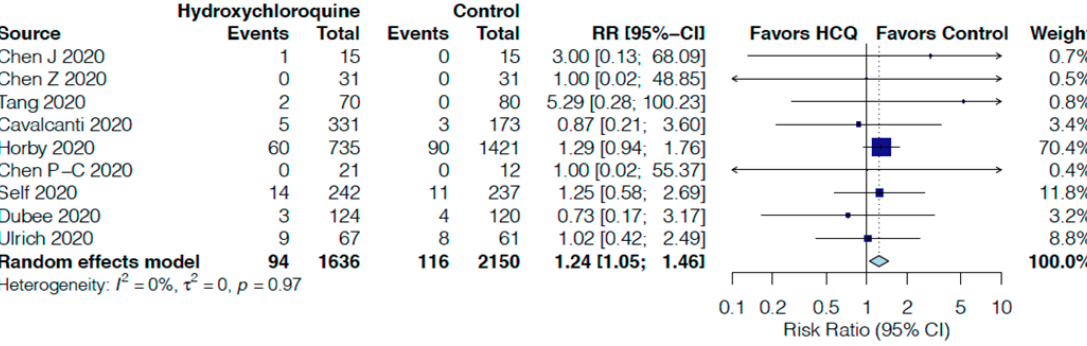
Figure 6. Effect of hydroxychloroquine on serious adverse events (SAEs) in hospitalized COVID-19 patients.